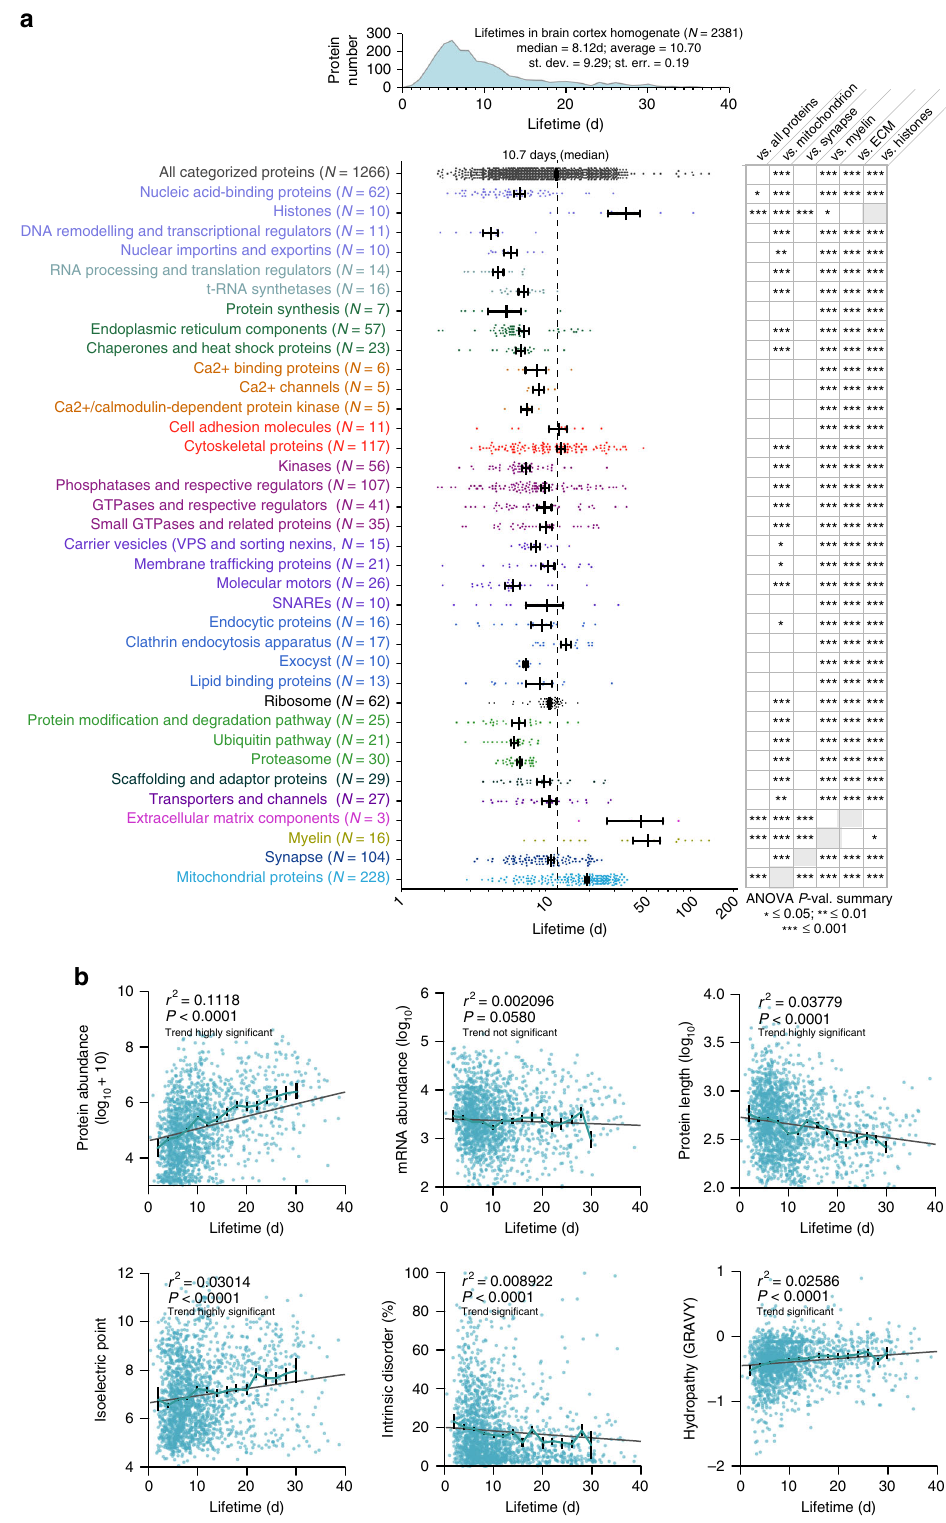
synaptic vesicle, the accessory proteins tended to be short-lived, while the core proteins are were longer-lived, on average (Fig. 3d). To categorize protein lifetimes in a complementary unbiased approach, we used a fuzzy c-means clustering algorithm, coupled to a functional enrichment 33 analysis of the identi fi ed proteins in non-redundant gene ontology (GO)-